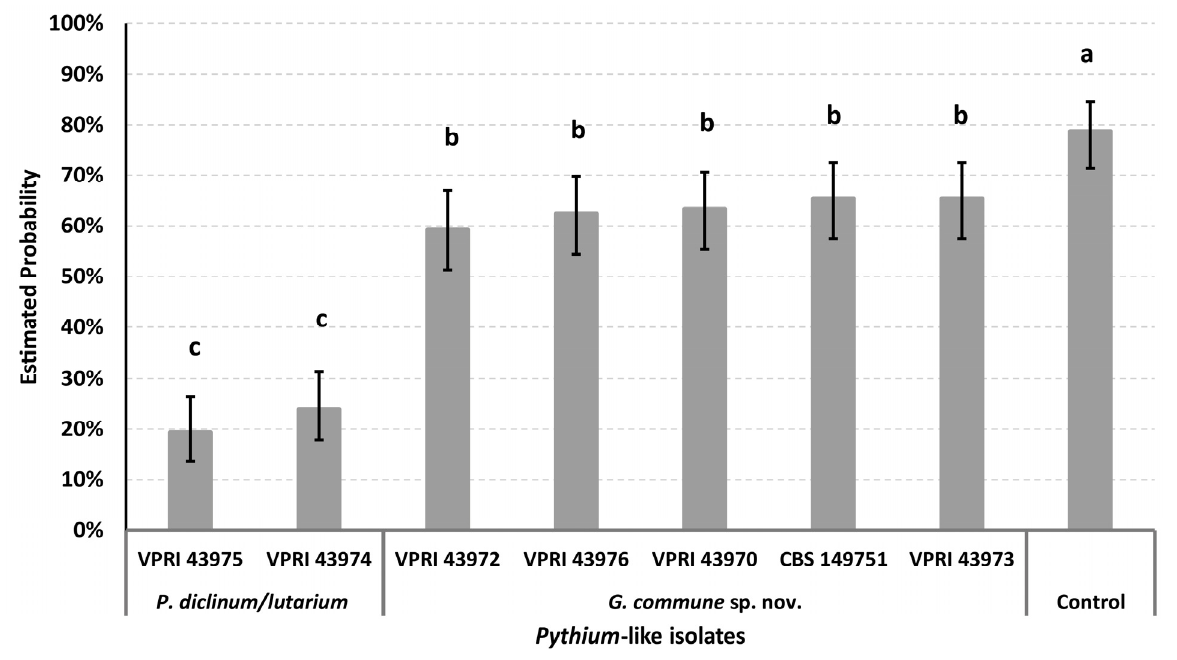
Figure 6. Predicted probability of pyrethrum seed germination inoculated with Pythium diclinum/lutarium and Globisporangium commune sp. nov. isolates, as calculated by the binary logistic regression model. Error bars show 95% confidence limit. Groups that do not share the same letter are significantly different by combination of odds ratios with 95% Wald confidence limits.